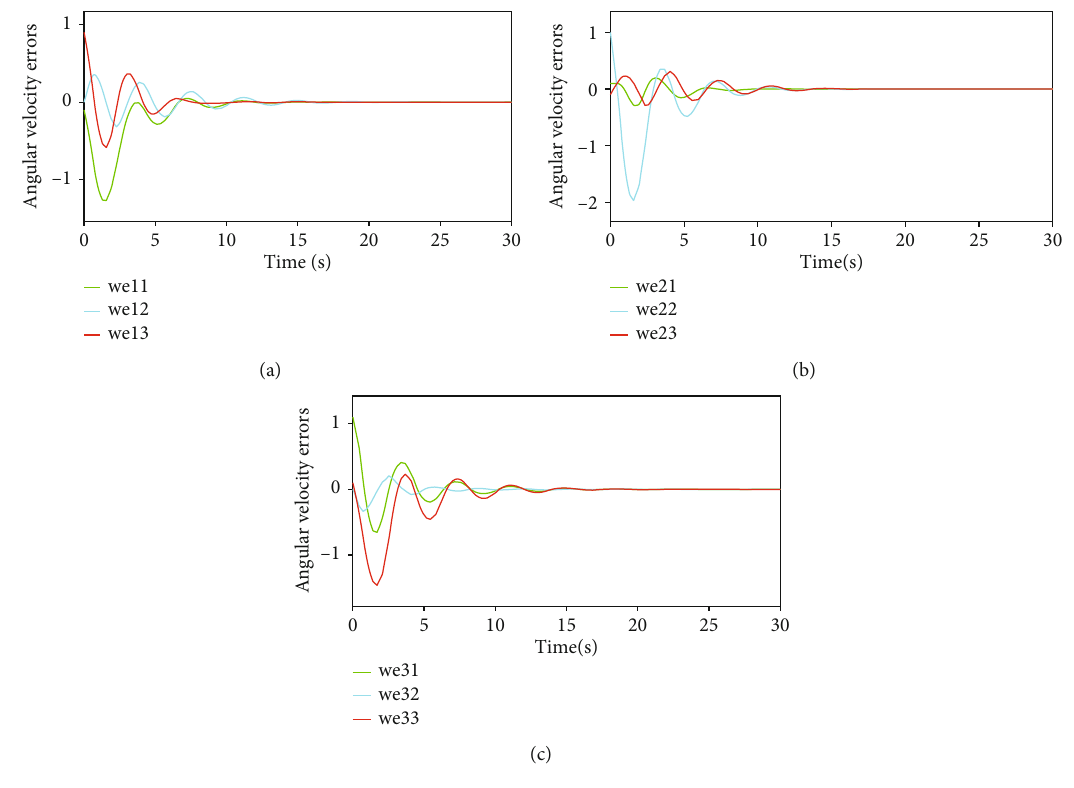
Figure 6: Angular velocity